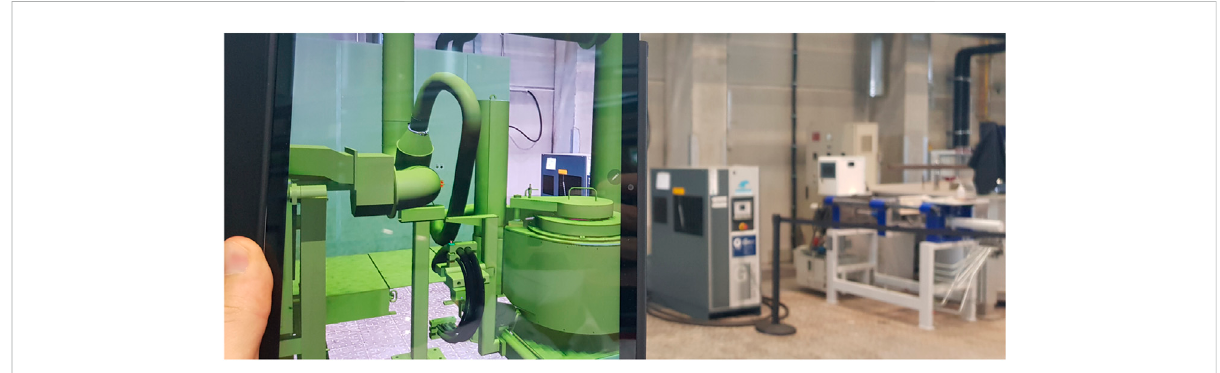
FIGURE 7 Augmentationofanindustrialsitewiththe fl